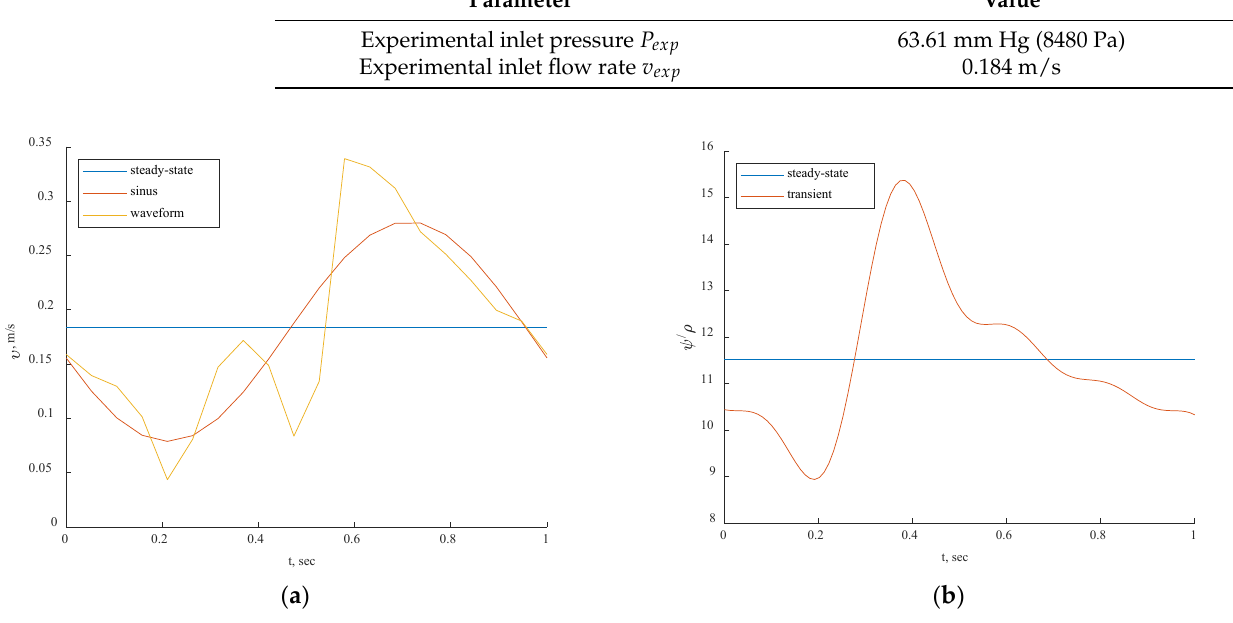
Figure 8. ( a ) Inlet boundary conditions: steady-state velocity waveform of left main coronary blood flow (adapted from [22]) and sinus flow: u(t) = 0.184 m/s − 0.02432 m/s*cos(2π*t) - 0.09822m/s*sin(2π*t) . ( b ) Inlet boundary conditions: normalized steady-state pressure and normal- ized transient waveform pressure.